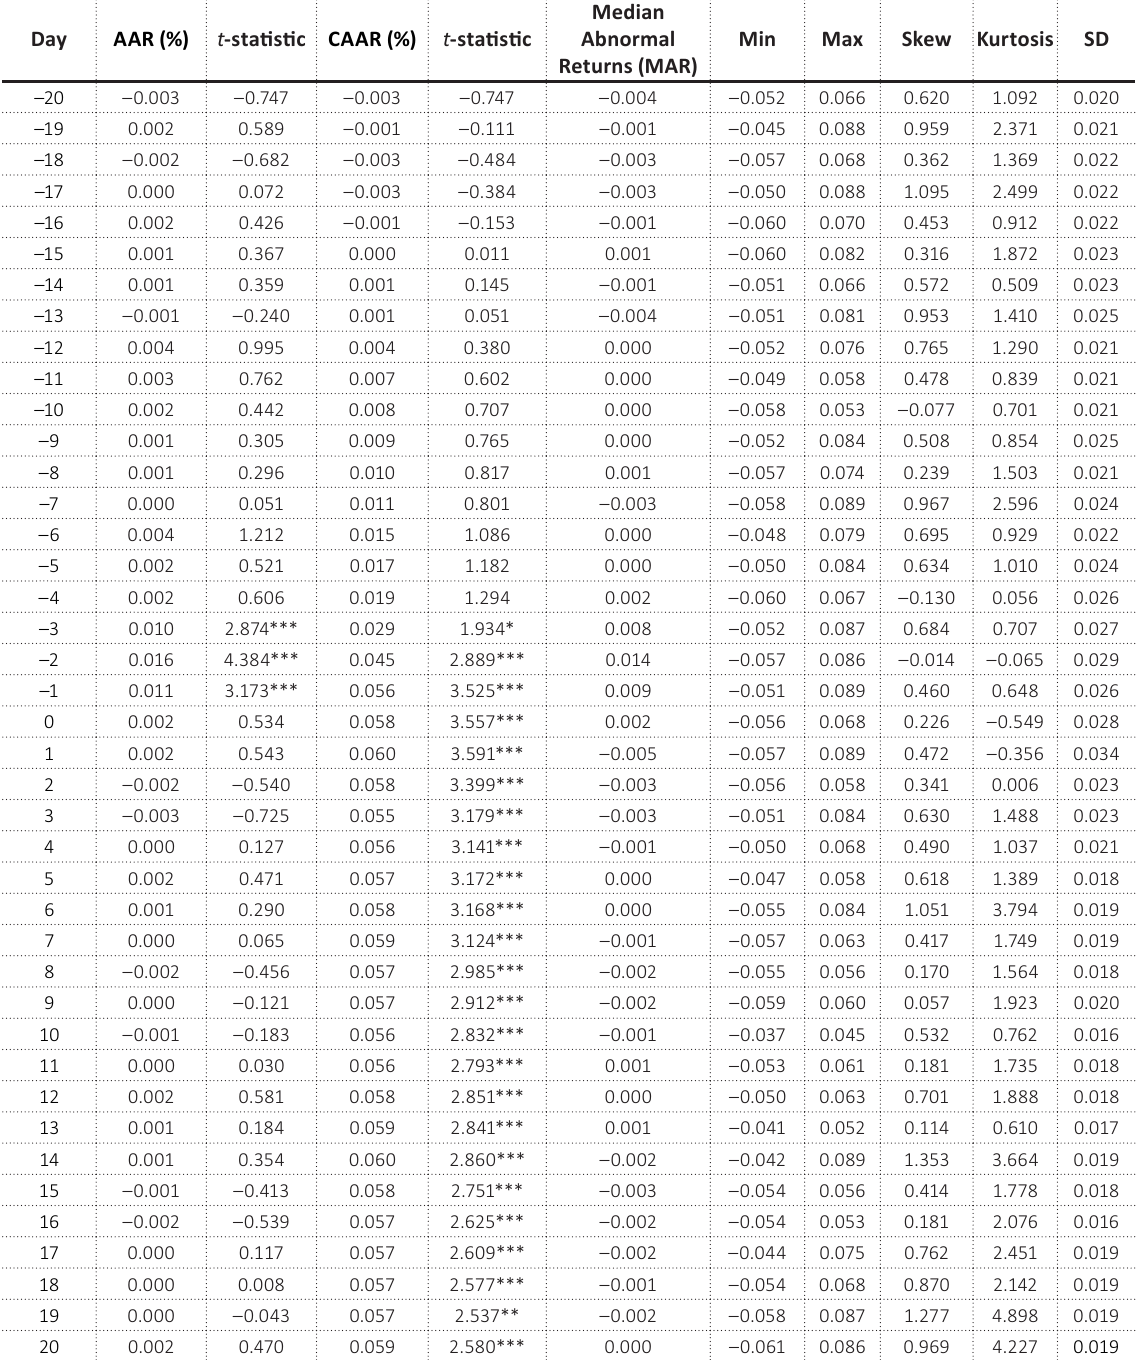
Table 2. Average abnormal returns (AAR)